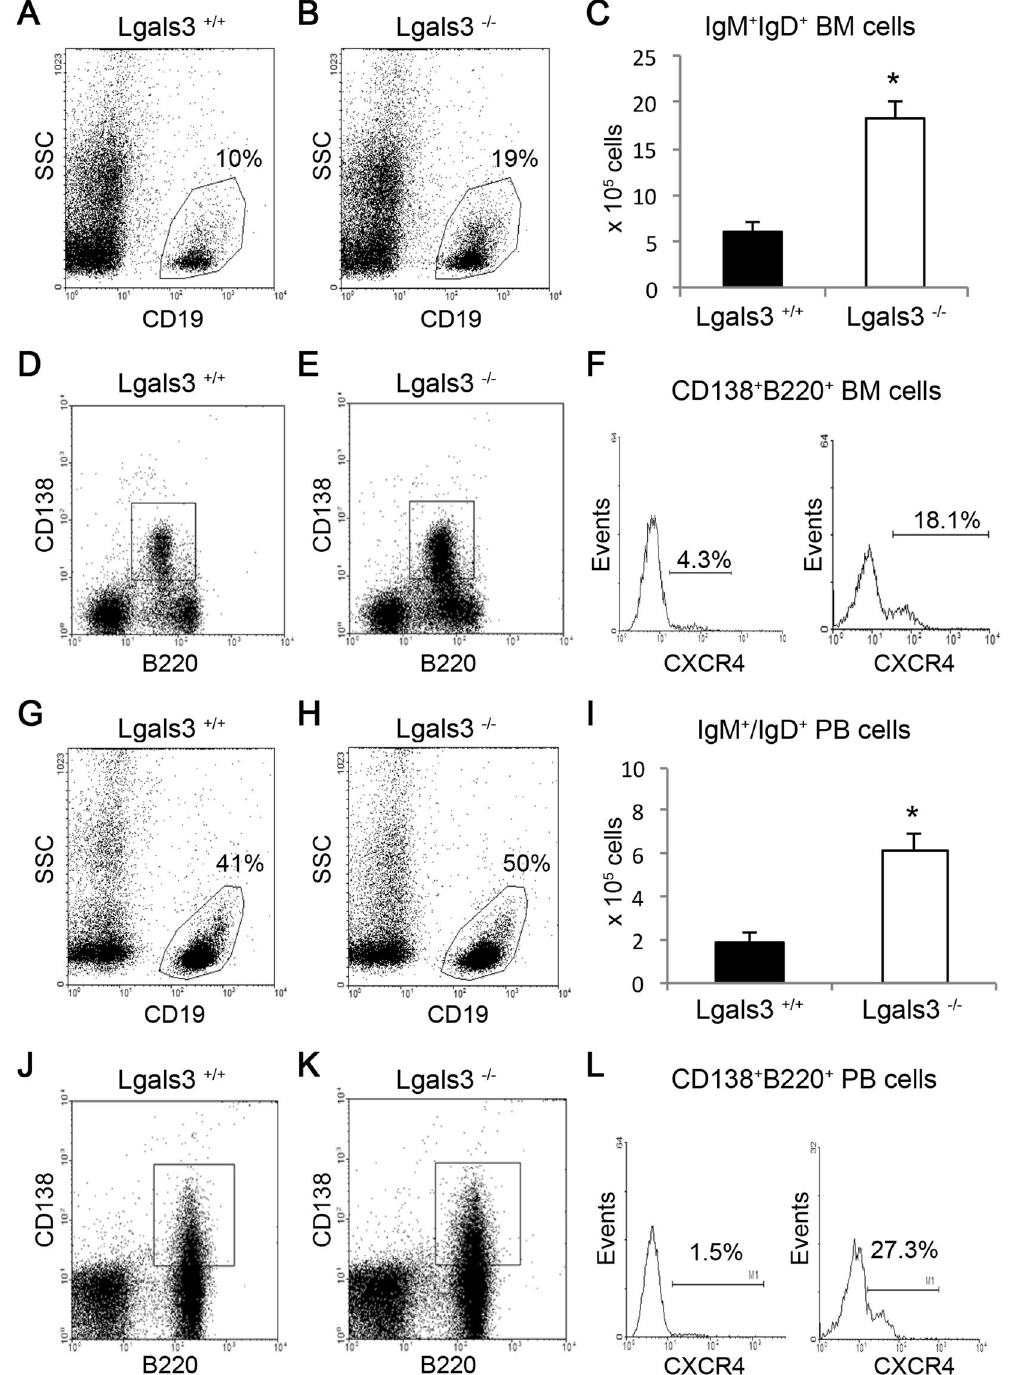
Figure 7. Kinetics of IgM + IgD + and B220 + CD138 + CXCR4 + cell subpopulations in the absence of galectin-3. Percentage of total CD19 + B cells in the bone marrow of Lgals3 + / + ( A ) and Lgals3 − / − mice ( B ). ( C ) Absolute number of the bone marrow CD19 + B cells. Percentage of total B220 + CD138 + B cells in the bone marrow of Lgals3 + / + ( D ) and Lgals3 − / − mice ( E ). ( F ) Percentage of B220 + CD138 + CXCR4 + plasmablasts in the bone marrow of both Lgals3 + / + and Lgals3 − / − mice. Percentage of total CD19 + B cells in the blood of Lgals3 + / + ( G ) and Lgals3 − / − mice ( H ). ( I ) Absolute number of CD19 + B cells in the bloodstream of both mice. Percentage of total B220 + CD138 + B cells in the blood of Lgals3 + / + ( J ) and Lgals3 − / − mice ( K ). ( L ) Percentage of B220 + CD138 + CXCR4 + plasmablasts in the bloodstream of Lgals3 + / + and Lgals3 − / − mice. n = 5 mice per group. ( * ) Indicates p <